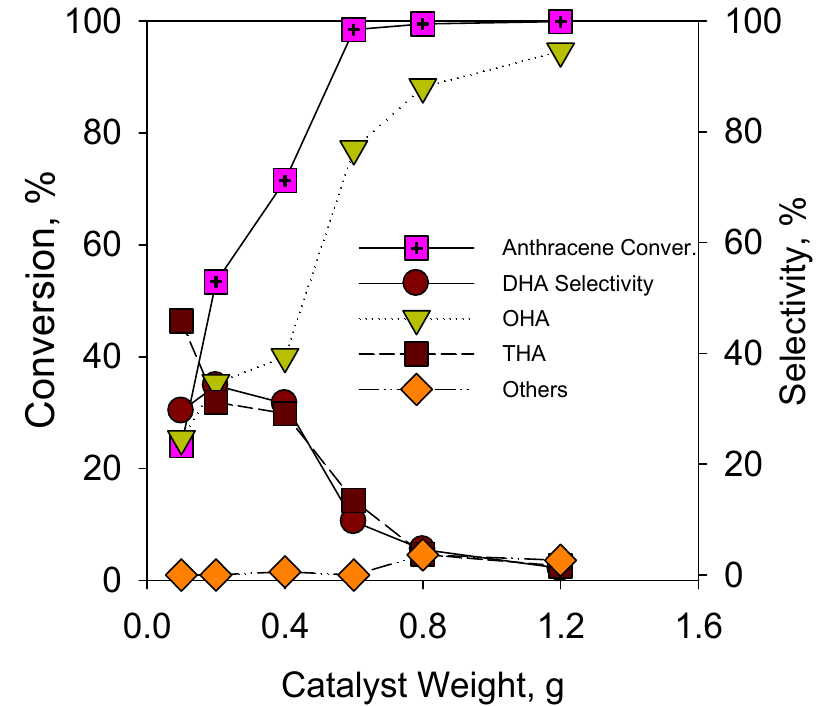
Figure 7. Effect of catalyst weight on hydrogenation of anthracene over 40% Ni/H β -zeolite catalyst. Reaction temperature: 100 °C; Reaction pressure: 6.9 MPa; H 2.76 MPa; volume of the reactor: 50 mL; reaction time: 6